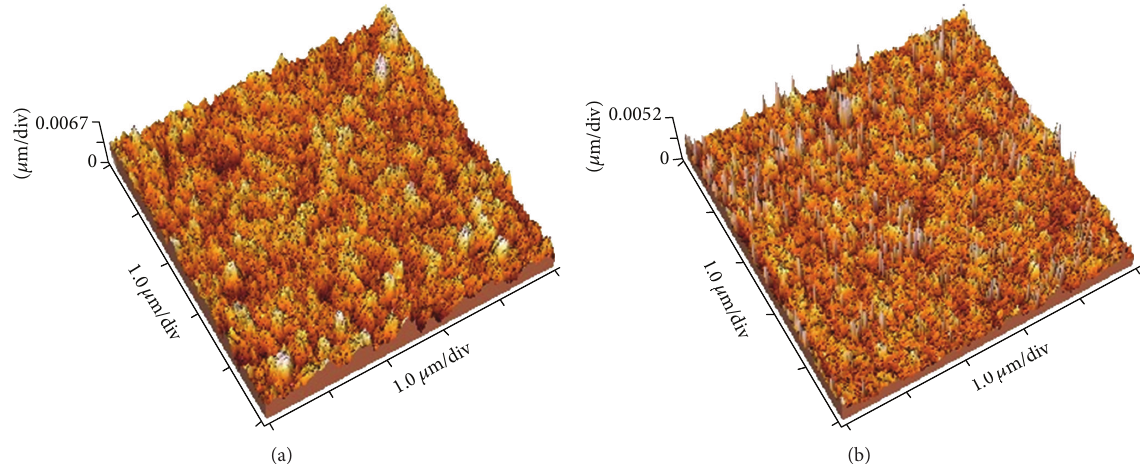
Figure 5: Top surface AFM images of Mo films prepared at a sputtering power of 100W and working pressures of (a) 4.5 mTorr and (b)